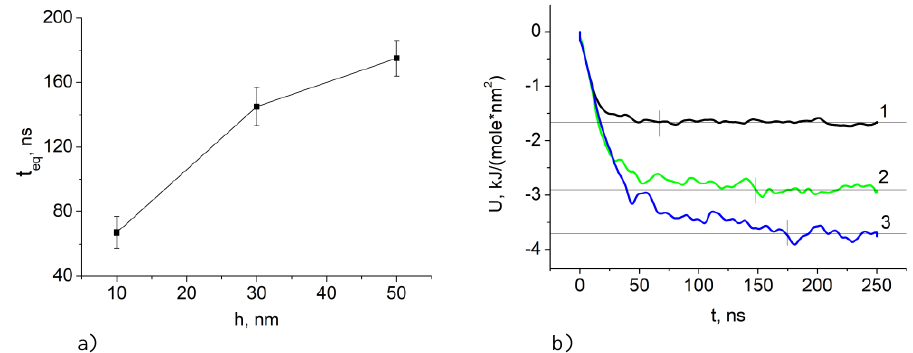
Fig. 2. (a) The dependence of the time needed to reach the equilibrium distribution of molecules on the size of the nanopore. (b) The interaction energy between the nanopore wall and PCN molecules as a function of time. Curve 1 – pore width 10 nm, 2 – 30 nm, 3 – 50 nm. Average density – 0.035 molecules/nm